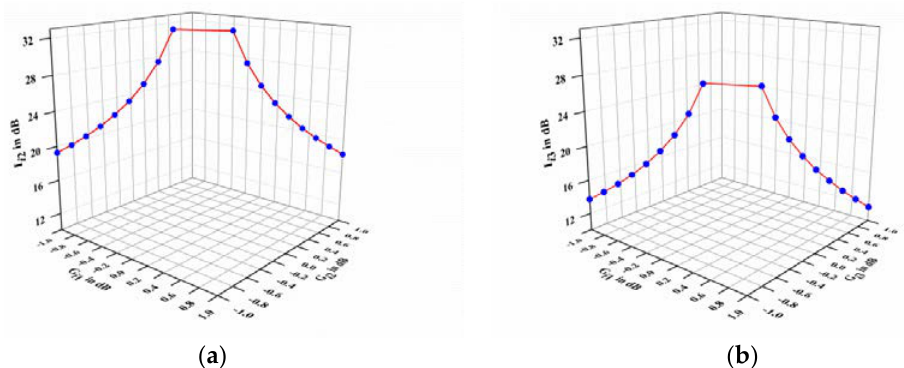
Figure 2. Computational results in the i th channel: ( a ) the improvement degrees of the second-order nonlinear term ( I i ₂ ); ( b ) the improvement degrees of the third-order nonlinear term ( I i ₃ ). Table 1. The maximum and minimum absolute values of PE i versus different frequency points.